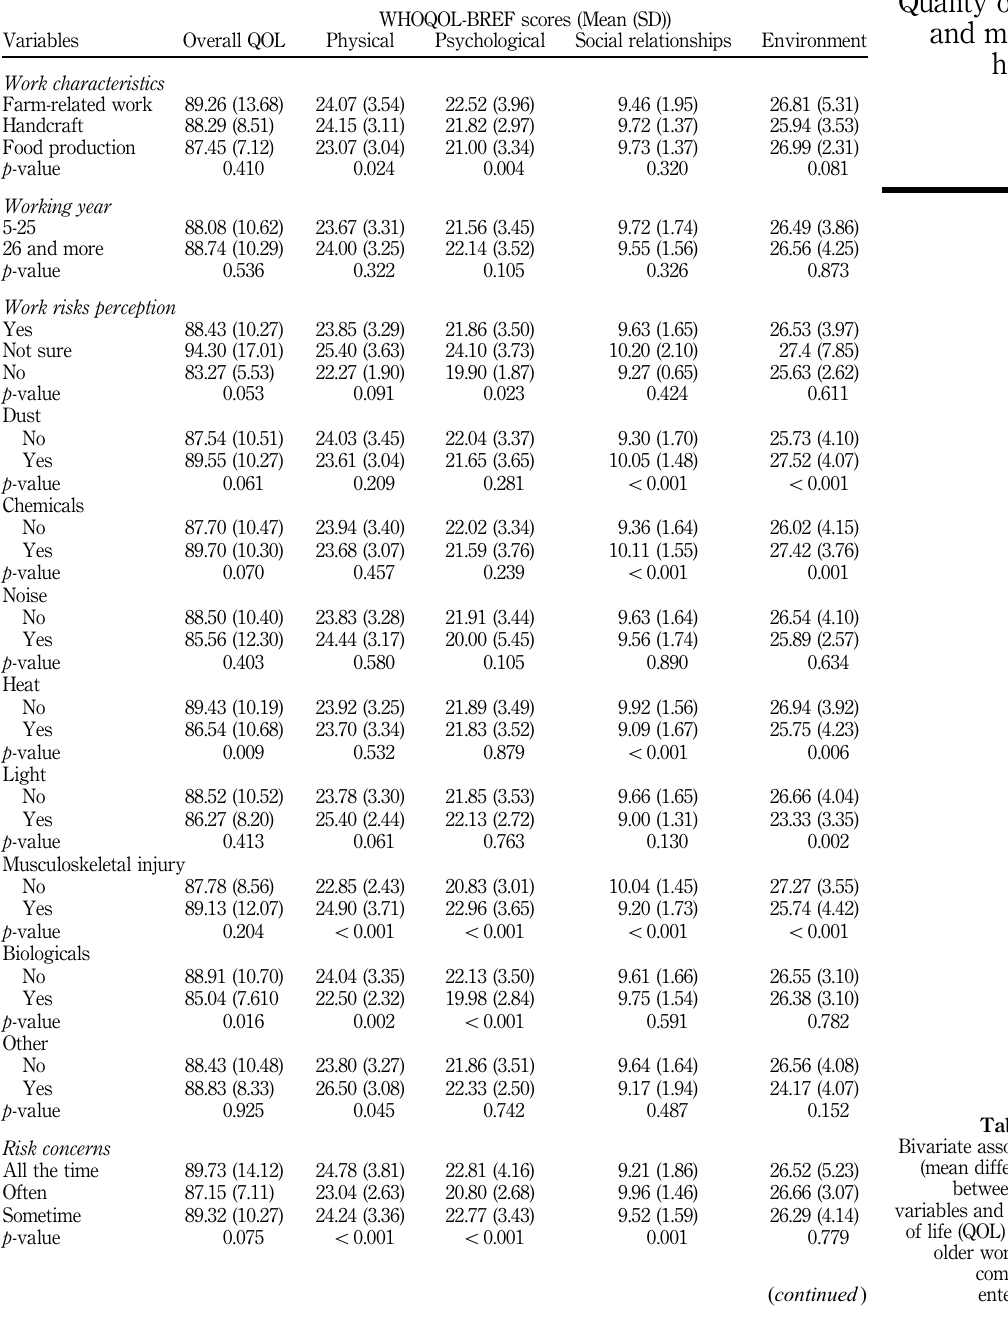
Table IV. Bivariate association (mean differences) between work variables and quality of life (QOL) among older workers in